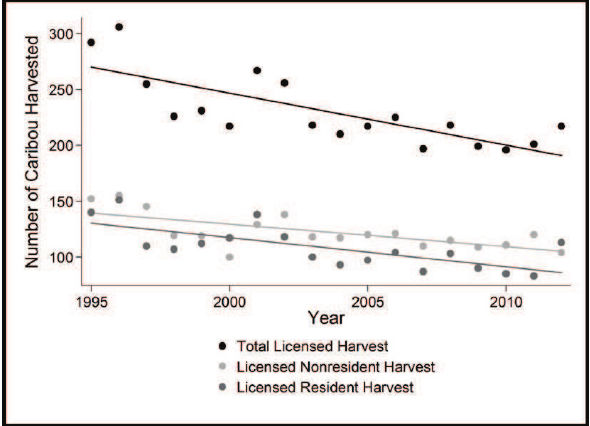
Fig. 4. Licensed harvest of northern mountain caribou (1995 – 2012) in Yukon, Canada. Trend lines indicate decreasing total licensed harvest ( b = -4.65, SE = 0.96) for both non-resident ( b = -2.02, SE = 0.53) and resident ( b = -2.60, SE = 0.63)